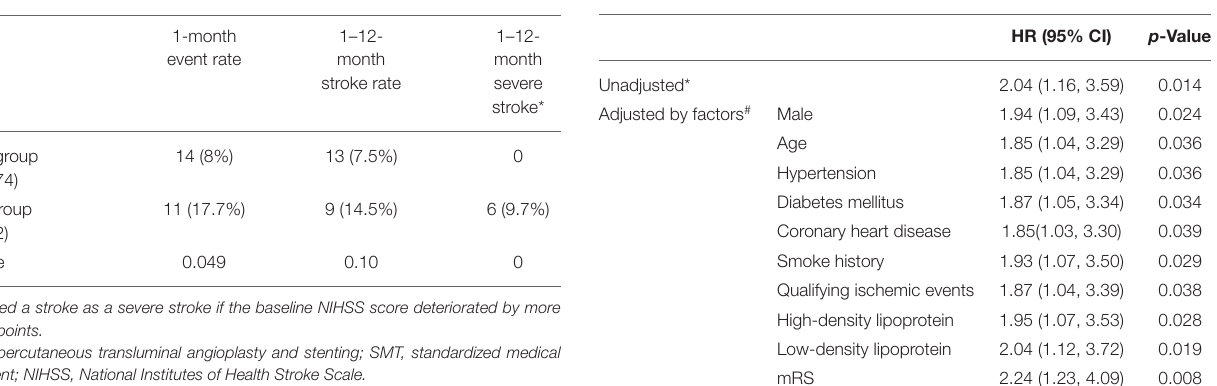
TABLE 5 | Comparison of the primary endpoints using the Cox proportional hazards model adjusted by various